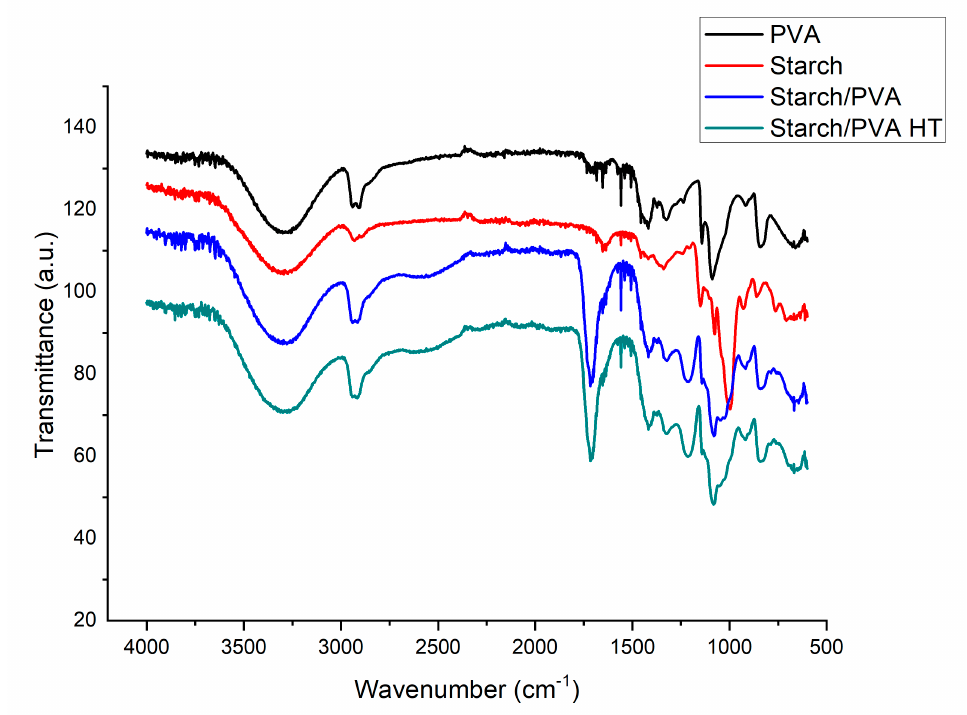
Figure 6. FTIR spectra of PVA, starch, starch/PVA and starch/PVA HT.